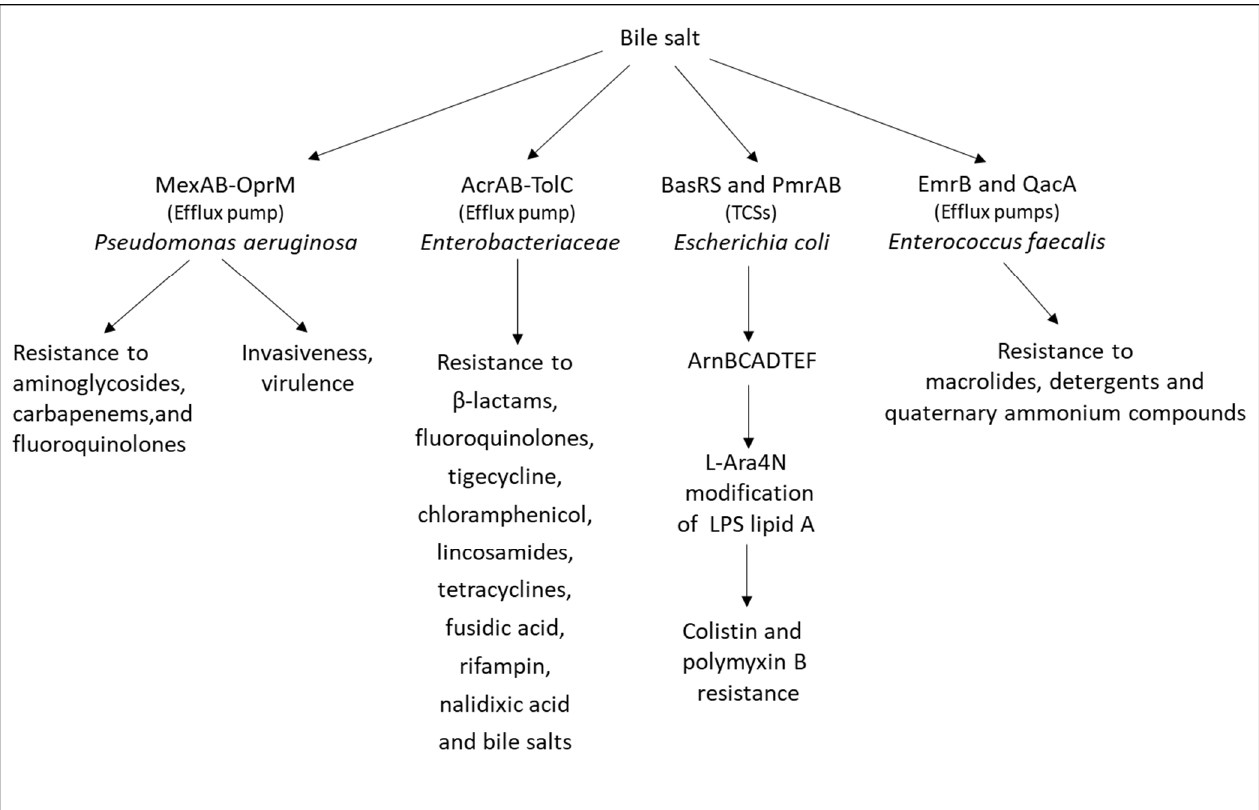
Figure 3. Examples of antibiotic resistance mechanisms induced by bile acids. Bile salts which are secreted into the duodenum, induce the expression of various genes in bacteria that confers antibiotic resistance. Outstanding is the upregulation of efflux pumps such as MexAB-OprM in Pseudomonas aeruginosa , AcrAB-TolC in Enterobacteriaceae and EmrB/QacA in Enterococcus faecalis that confer resistance to multiple antibiotics and antiseptics, as well as to the bile salts themselves. Additionally, the TCSs BasRS and PmrAB are induced in Escherichia coli , resulting in the upregulation of the arnBCADTEF operon responsible for the L-Ara4N modification of LPS. This modification reduces the affinity of colistin/polymyxin B to LPS, with consequent resistance to these drugs. The metabolite indole that is produced by the degradation of tryptophan by